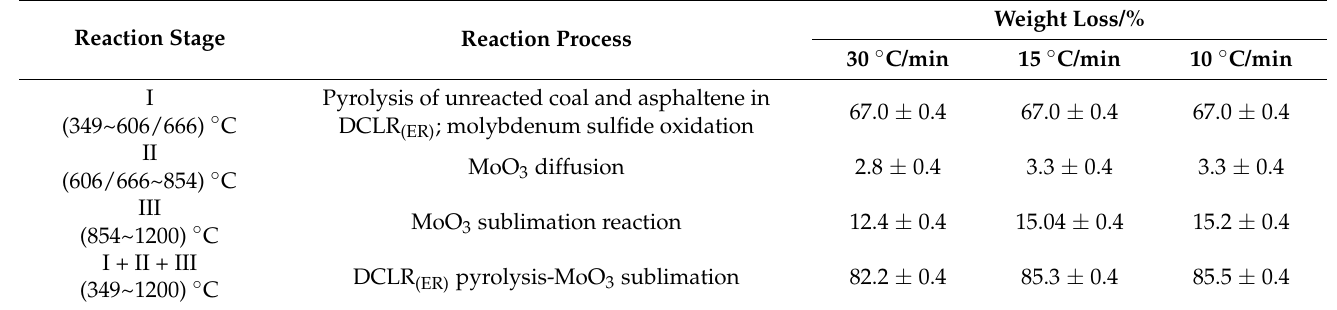
Table 2. Results of DCLR (ER) -MoS 2 thermal analysis at different heating rates.